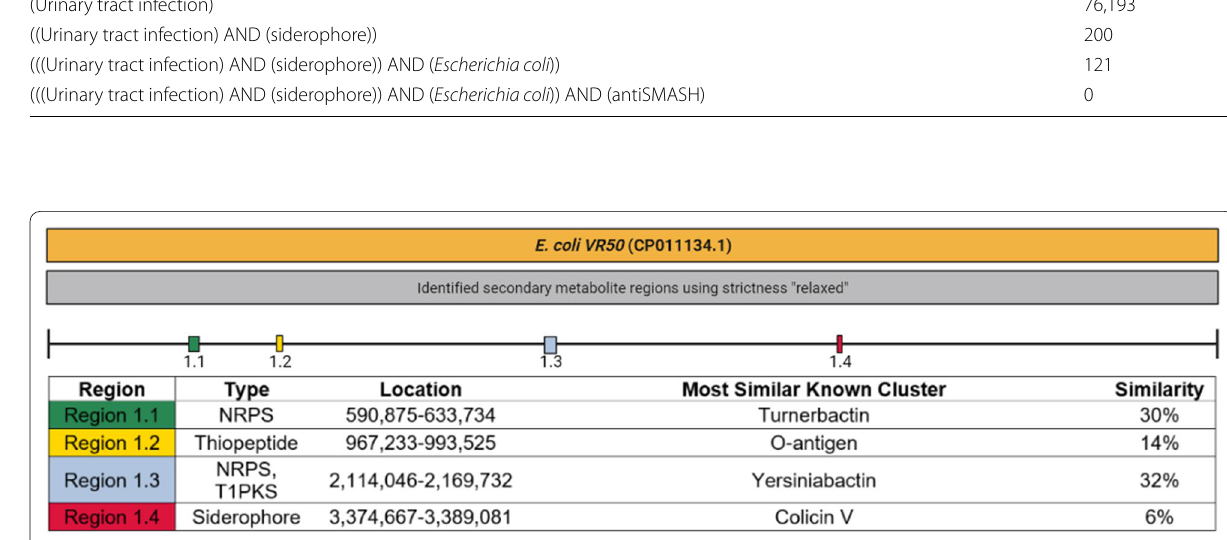
Fig. 1 Identified secondary metabolite regions in E. coli VR50 (NCBI Accession number: CP011134.1) and similar gene